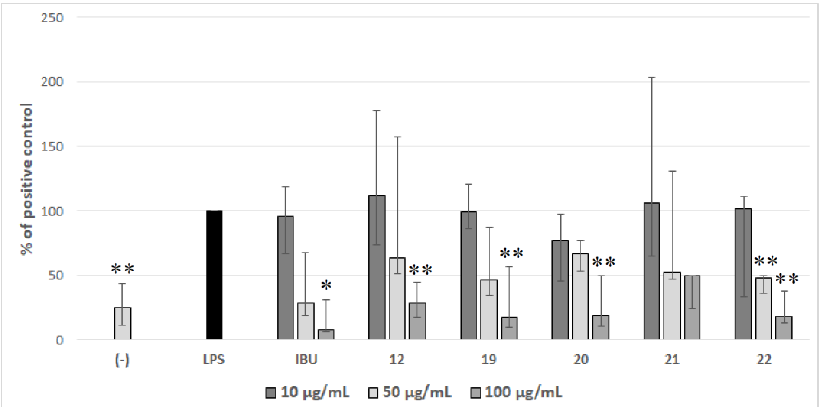
Figure 4. The effect of compounds 12 , 19 – 22 and IBU on the LPS-induced production of IL-10 in PBMC cultures (the results are shown as percentage of positive control (LPS alone), with values expressed as medians from five independent experiments and confidence intervals); * indicates sig- nificant difference comparing to positive control (LPS alone) at 0.01 < p < 0.05; ** indicates a signifi- cant difference compared to positive control at p < 0.01.